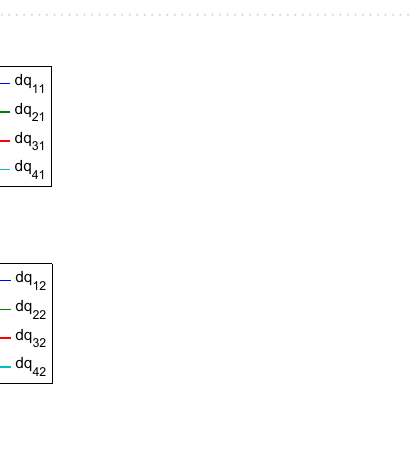
Figure 7. The velocities of four two-link manipulators associated with Fig. 6.